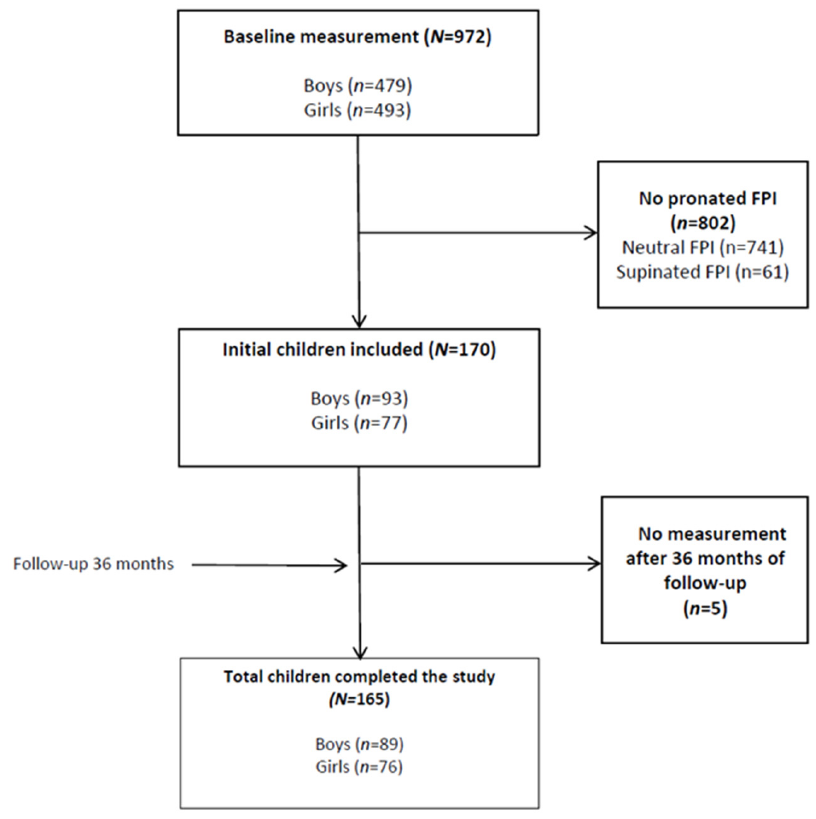
Figure 2. Schoolchildren selection process.